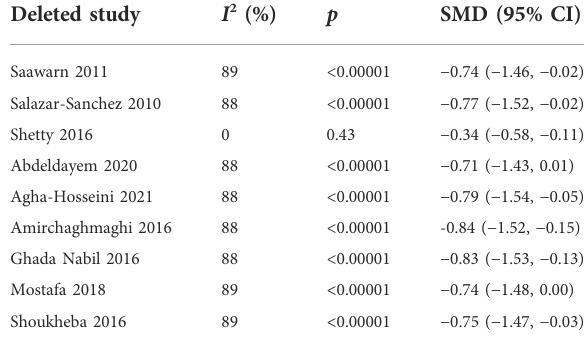
TABLE 2 Sensitivity analysis of pain scores using the method of eliminating studies one by one.